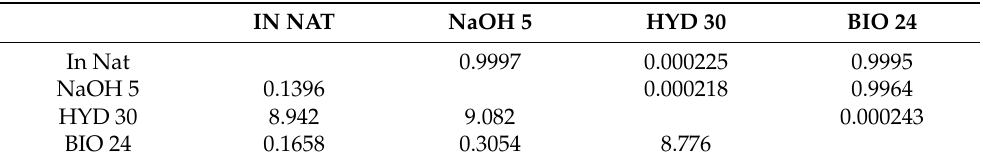
Table 6. Results obtained from the Tukey’s pairwise comparisons (Q/p) between the average values of the tensile strength of composites with 20% treated and untreated